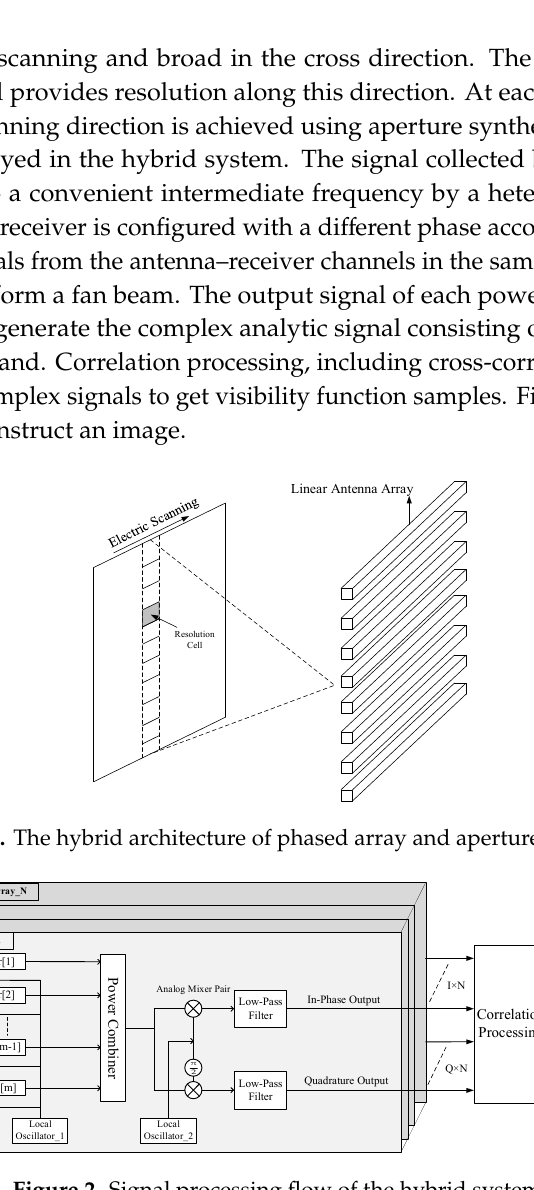
Figure 2. Signal processing flow of the hybrid system.